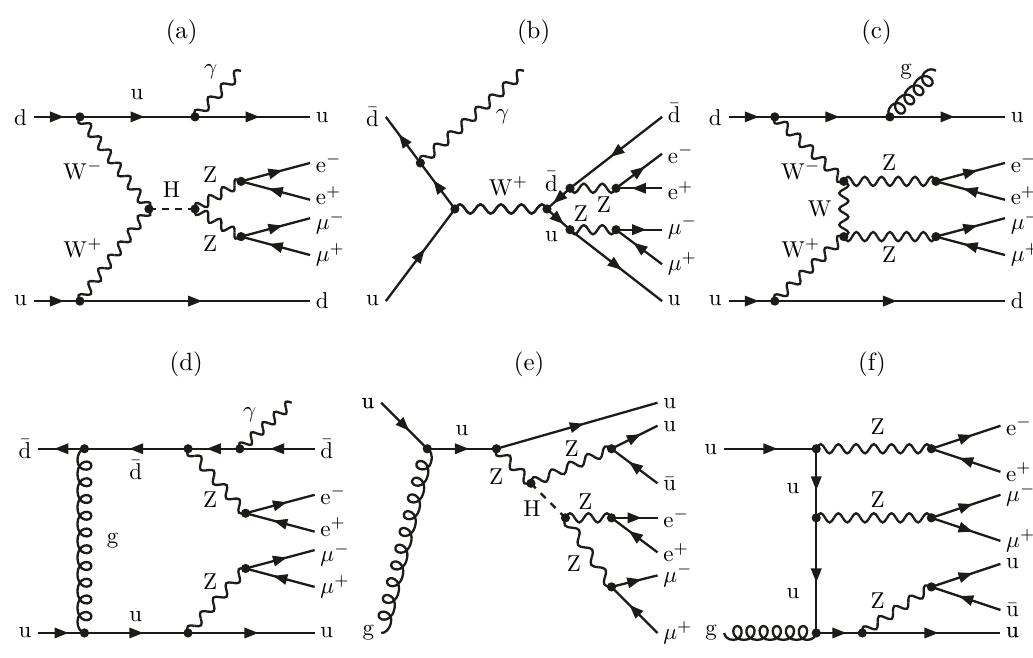
Figure 4. Sample diagrams for real